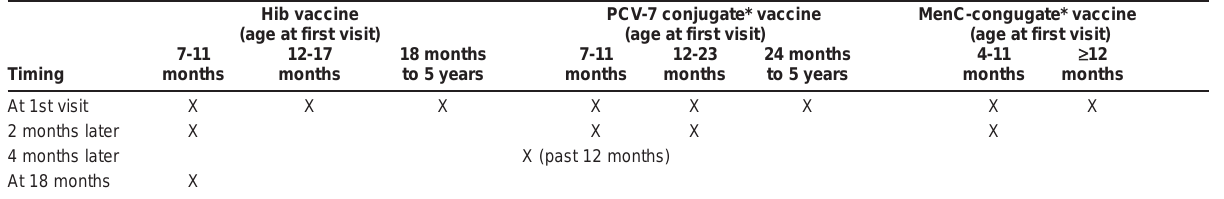
TABLE 4 Immunization schedule for vaccines against encapsulated bacteria for healthy children not previously immunized in the first three to six months of life Hib